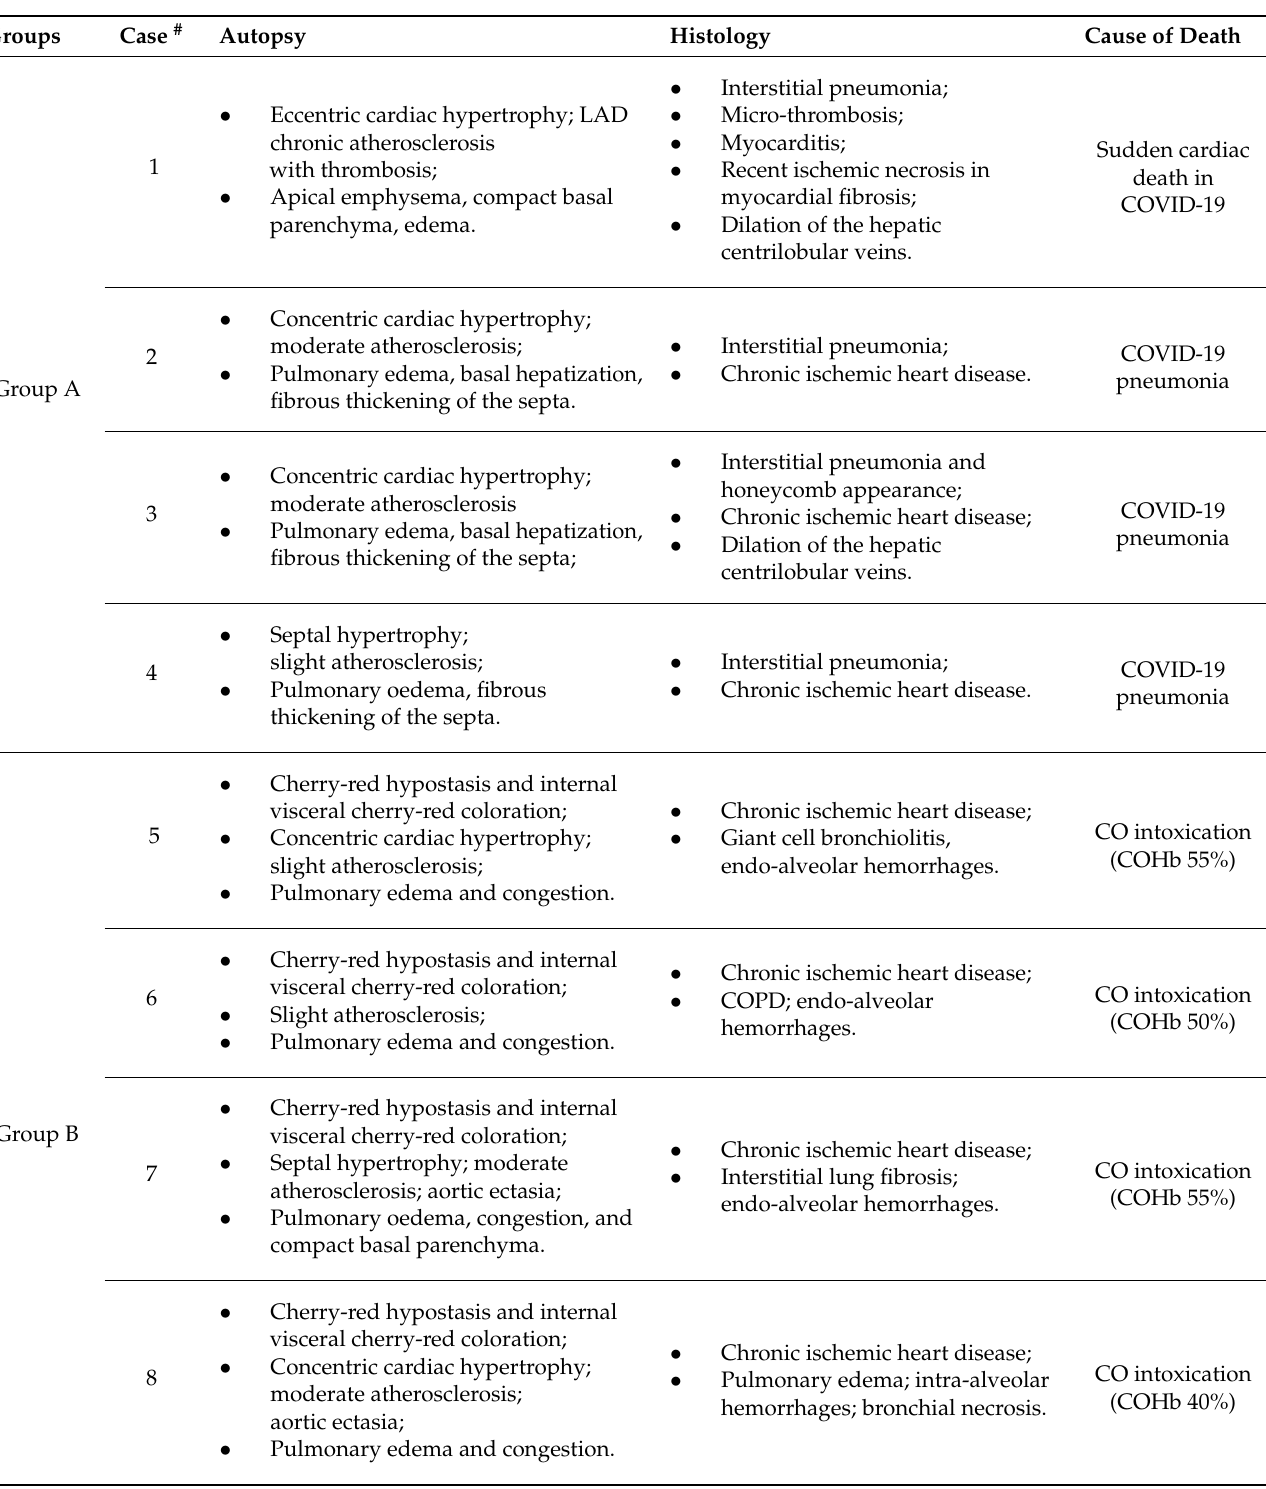
Table 2. Post-mortem findings and causes of